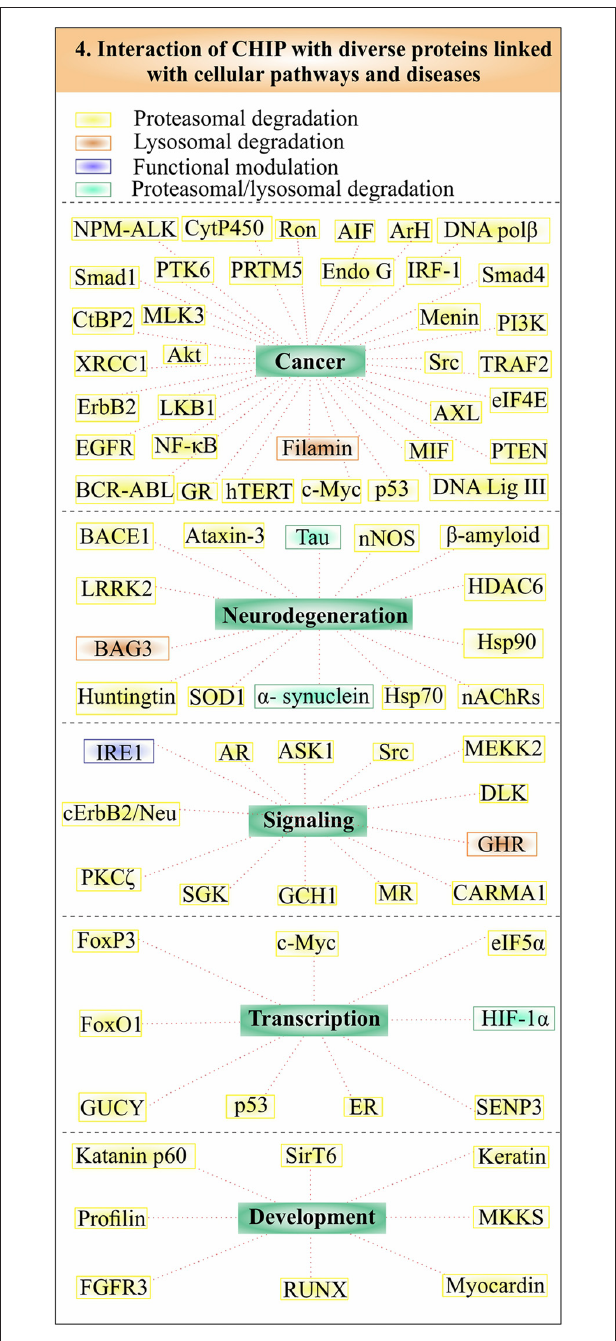
FIGURE 4 | CHIP linked substrates in multiple cellular pathways and abnormalities. CHIP substrates form a large group of proteins, implicated in various important pathways and pathologies. Substrates are subdivided in accordance with their association with cancer, neurodegeneration, signaling, transcriptional regulation and development. Substrates have been put into different boxes according to their degradative pathways. Yellow boxes represent substrates, which are degraded by the proteasome, whereas brown boxes represent the lysosomal degradation of CHIP substrates. Substrates degraded by both proteasomal and lysosomal pathways are shown in the green box. CHIP also ubiquitinates few of its substrates to functionally regulate them instead of degrading, shown within the purple